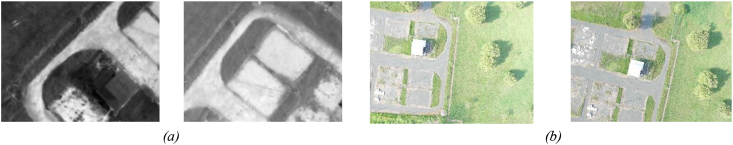
Four images of the dataset: (a) Two thermal images, (b) Two visible images.